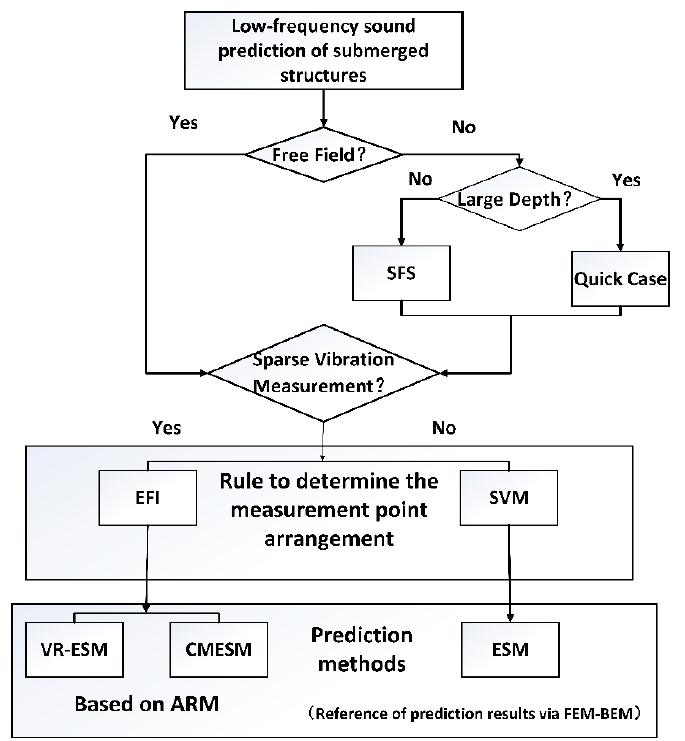
Figure 1. The flowchart illustrating the methodology of the paper. SFS, sound field separation; EFI, efficient independence; SVM, structural vibration mode; VR-ESM, vibration reconstruction equivalent source method; CMESM, compressed modal ESM; ARM, acoustic radiation mode; FEM, finite element method; BEM, boundary element method.